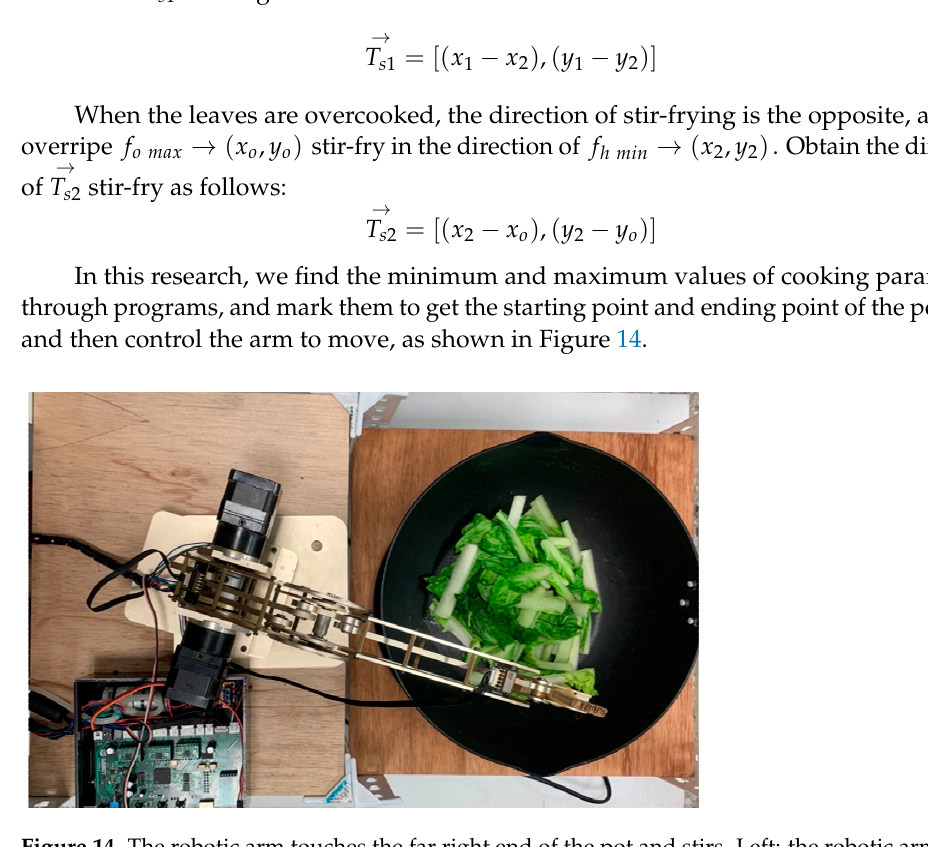
Table 3. ( A ) Identification rate of cabbage. ( B ) Identification rate of lettuce. ( C ) Identification rate of Pleurotus eryngii .